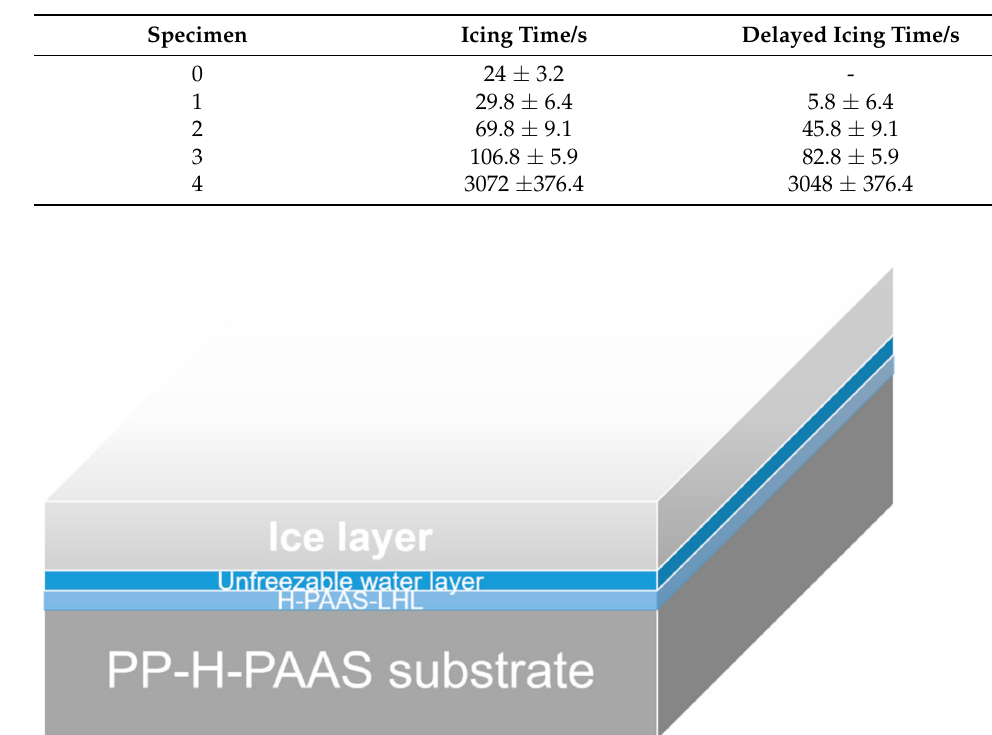
Figure 12. Scheme of H-PAAS lubricant hydrogel layer